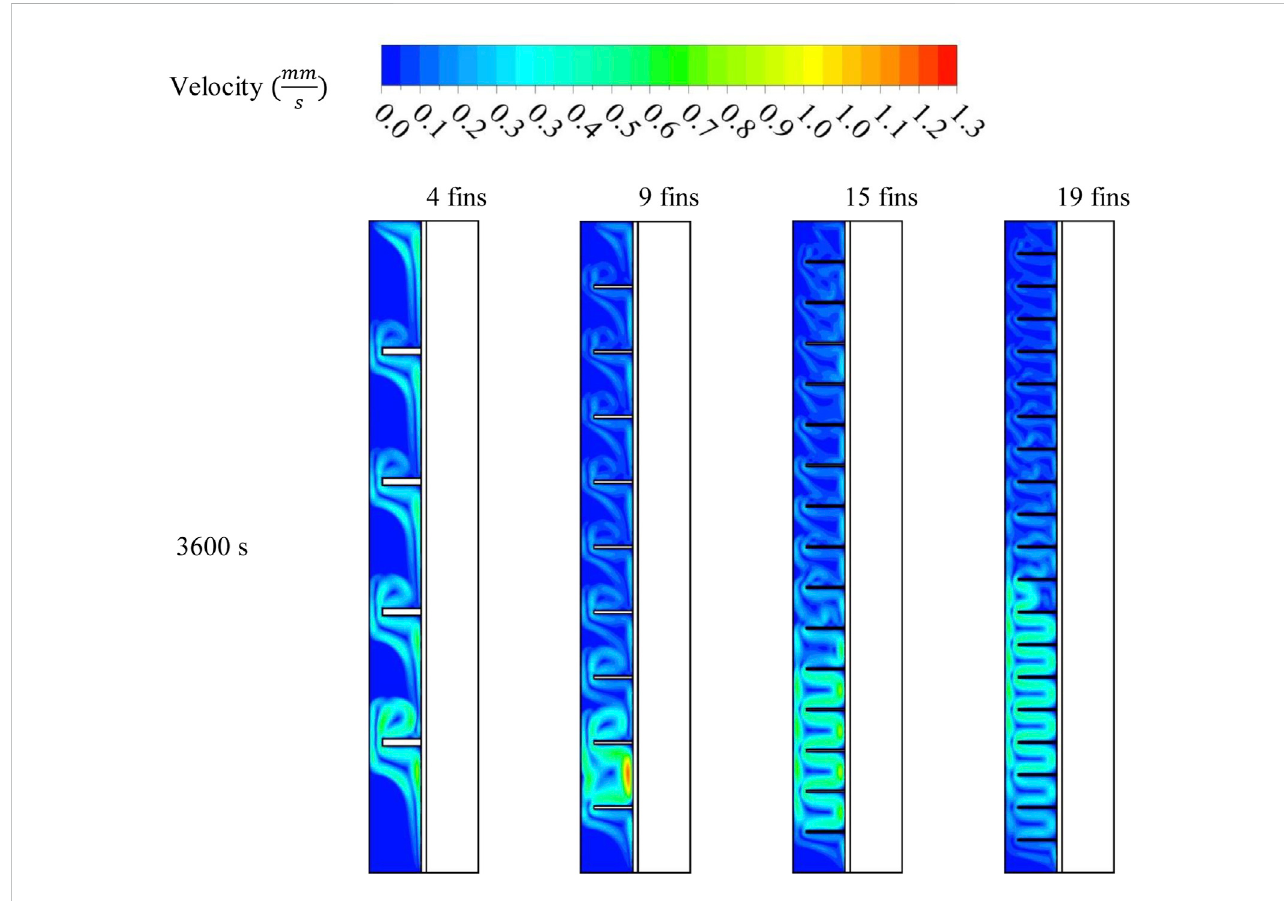
FIGURE 10 The velocity of the liquid phase of the PCM for different fi n numbers at 3,600 s.